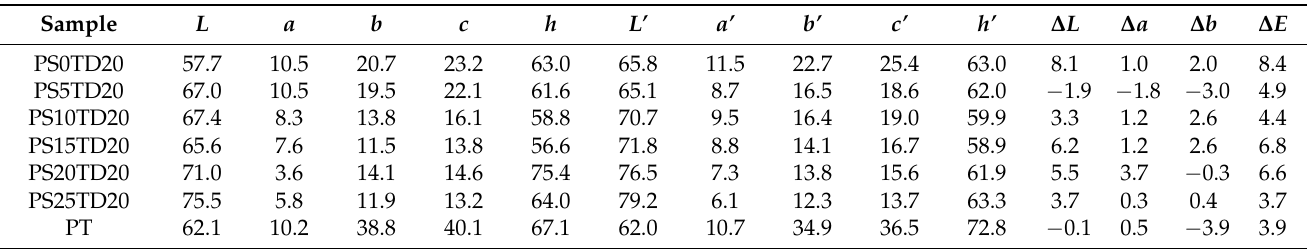
Table 4. The values of chromatism (normal atmospheric temperature is 26 ◦ C: L , a , b , c , and h